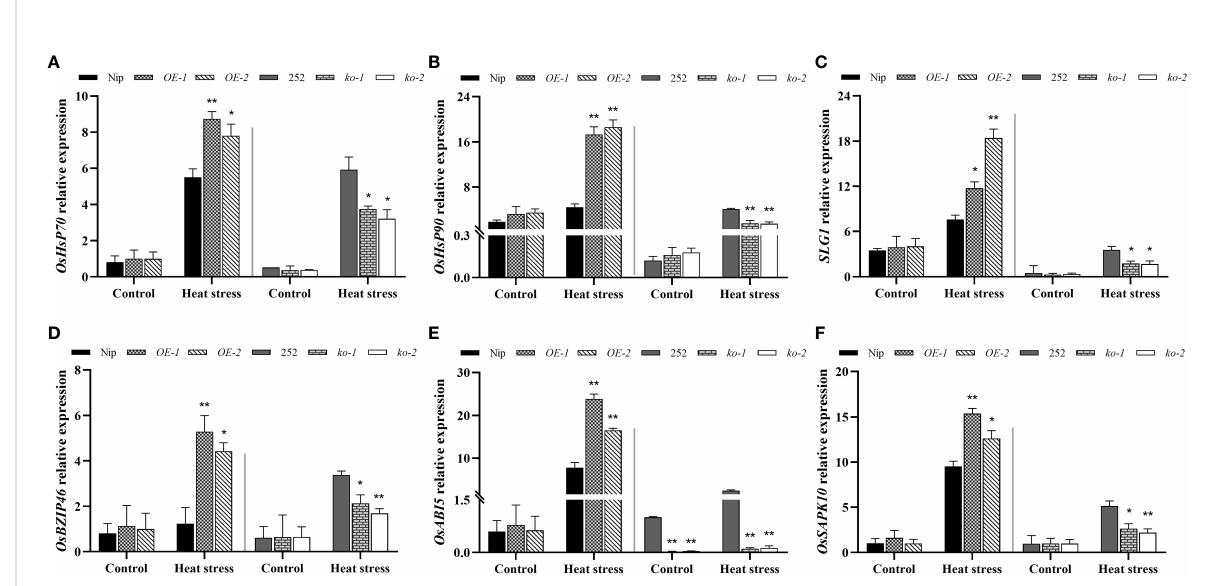
FIGURE 6 Transcriptional expression of heat tolerance and ABA related genes in WT and transgenic lines under heat stress. Three heat tolerance genes transcript levels of OsHSP70 (A) , OsHSP90 (B) , and SLG1 (C) . Seedlings of WT and transgenic lines were subjected to heat stress at 45°C for 48 h, and leaves were harvested for RNA extraction, cDNA synthesis and RT-qPCR analysis. For each RT-qPCR, rice reference gene OsActin1 was used as a control to detect its transcript levels in different samples. Data are means ± SD (n = 3; *p < 0.05, **p < 0.05, Student ’ s t -test). Three heat ABA related genes transcript levels of OsbZIP46 (D) , OsABI5 (E) , and OsSAPK10 (F) . Data are means ± SD (n = 3; *p < 0.05, **p < 0.05, Student ’ s t